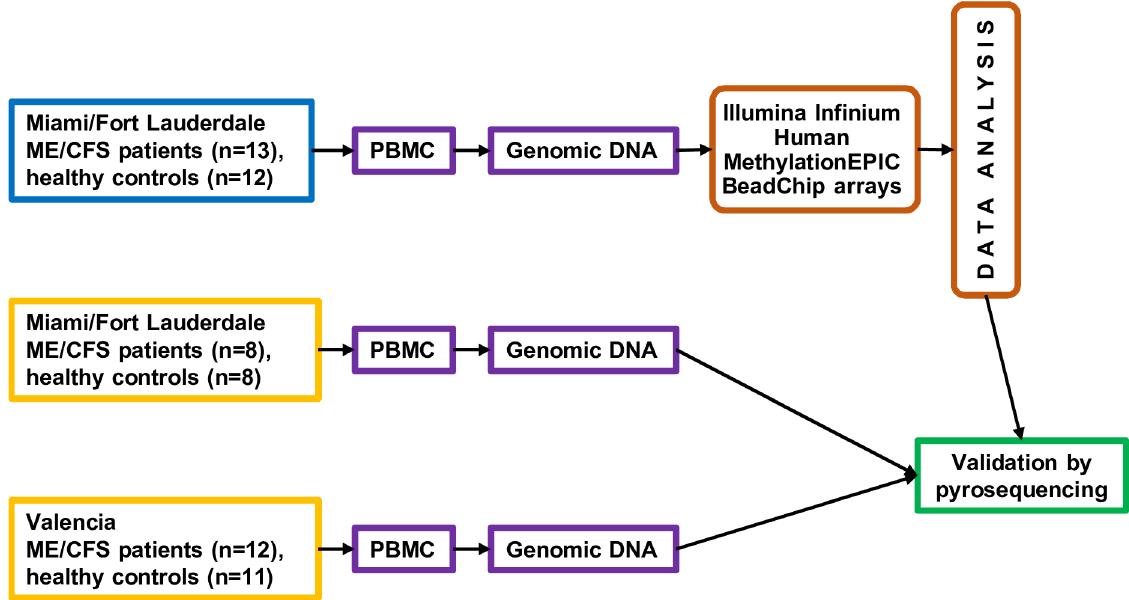
Fig 1. Study design flowchart. Genomic DNA was isolated from ME/CFS cases (N = 13) and controls (N = 12) and analyzed using Illumina Infinium Human MethylationEPIC BeadChip microarrays and this was defined as “experimental cohort”. Following data analysis results were validated on all the samples from the “experimental”, as well as from a secondary cohort that included samples from ME/CFS cases (N = 8) and controls (N = 8) from Miami/Fort Lauderdale area, as well as ME/CFS cases (N = 12) and controls (N = 11) from Valencia (Spain), using pyrosequencing